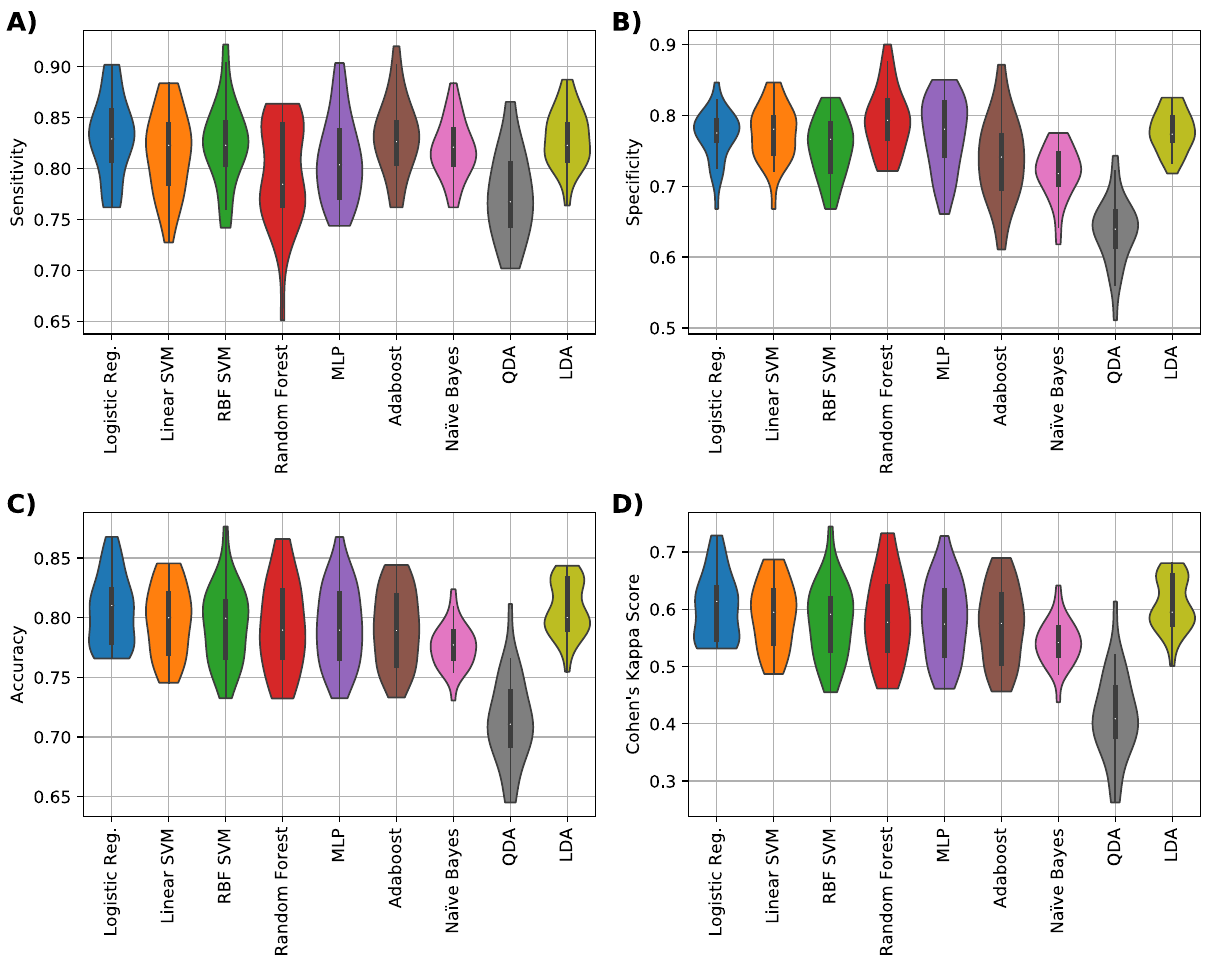
Figure 2. Performance metrics results for the data set composed with only all statistical relevant peaks. ( A ) Sensitivity, ( B ) Specificity, ( C ) Accuracy and ( D ) Cohen’s kappa values of nine different classifiers (logistic regression, linear SVM, RBF SVM, random forest, MLP NN, Adaboost, QDA and LDA) are